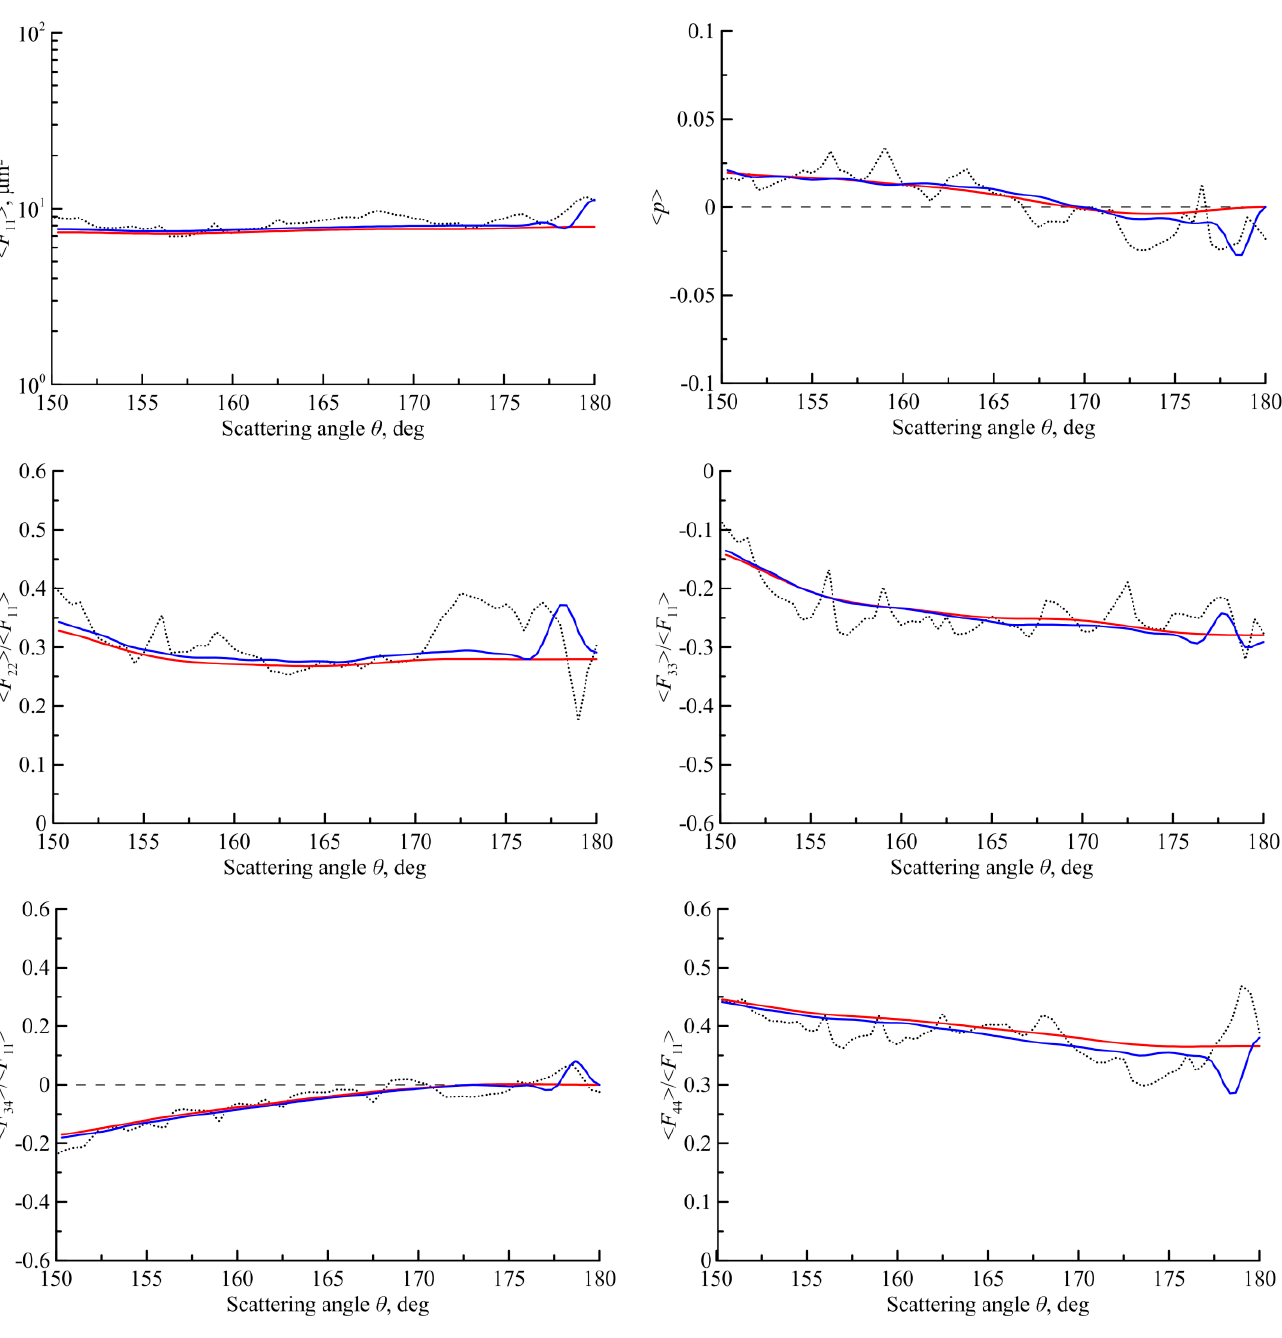
Figure 3. The scattering matrix for the shape 2 of Figure 1.